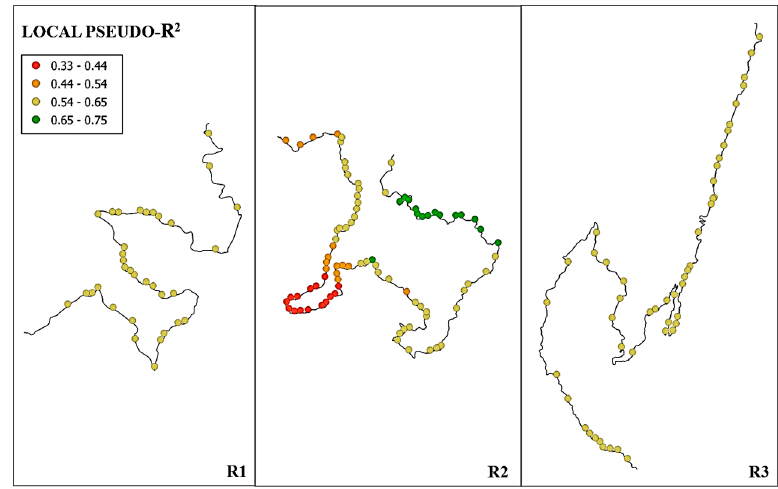
Figure 4. Local pseudo-R 2 of the GWR analysis in each surveyed road. In a gradient from red to green, the green points represent higher values of the local pseudo-R 2 .